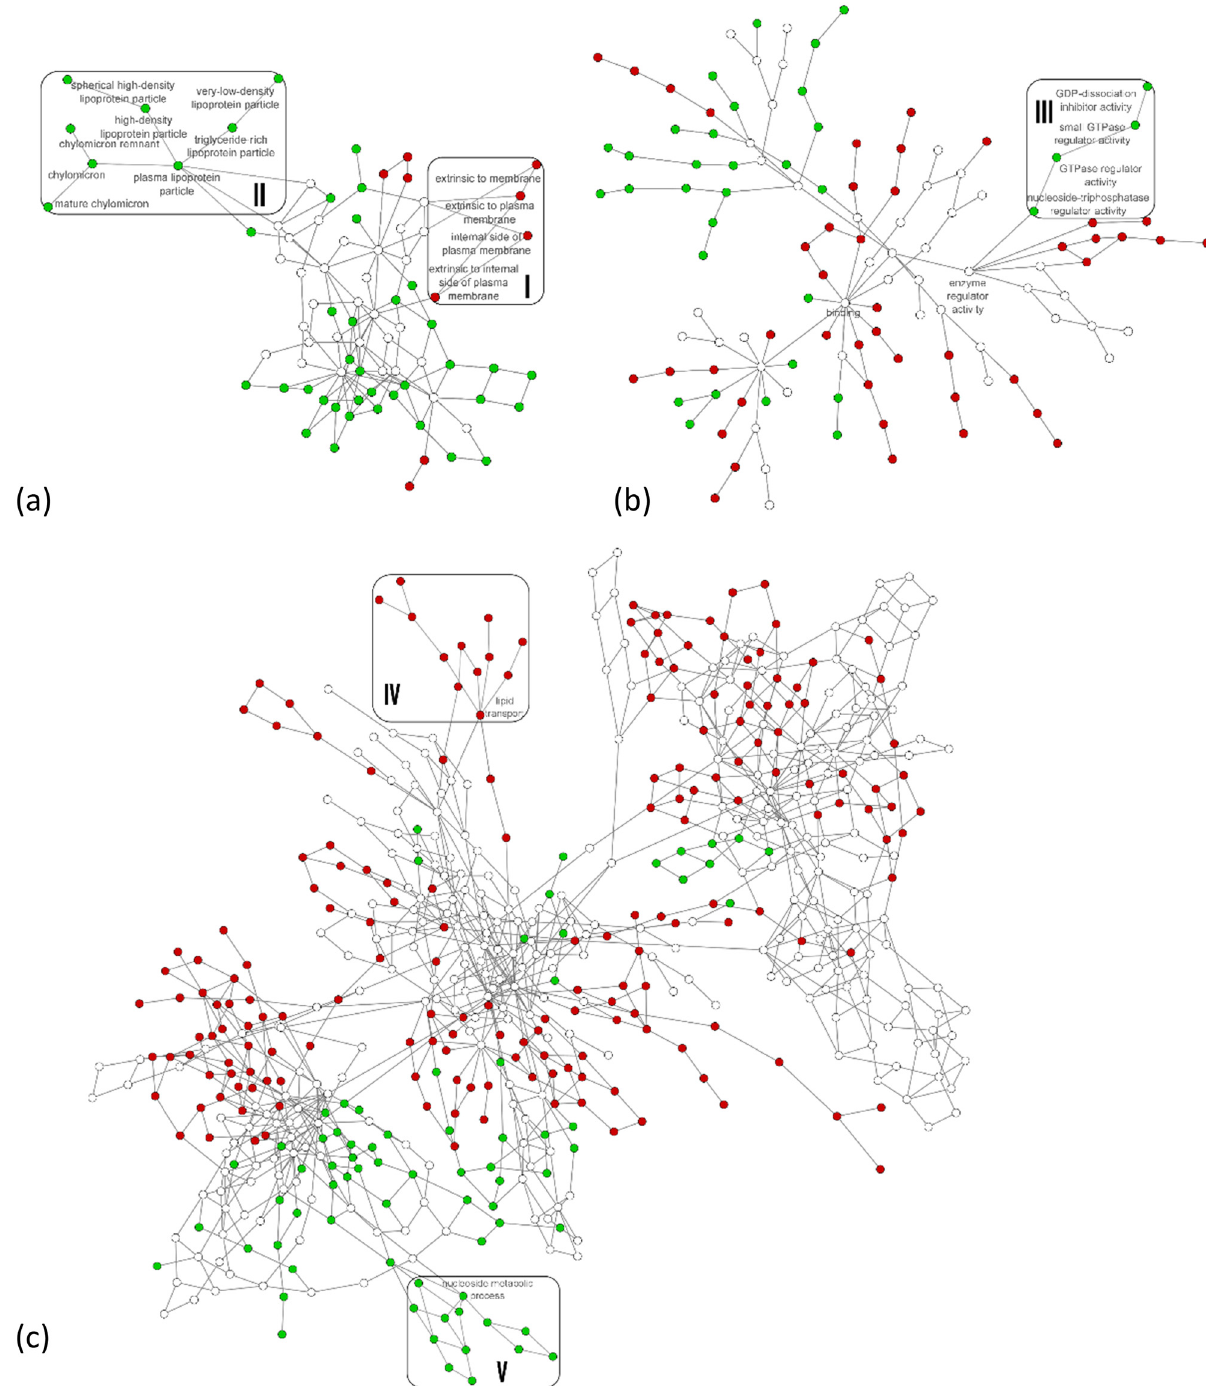
Figure 5: The hierarchical DyNet networks of GO categories: ( a ) GO cell component, ( b ) GO molecular function, and ( c ) GO biological process. Green circles – GO categories identi fi ed only by FASP protocol D1 ( Microcon ) , red circles – GO categories identi fi ed only by FASP protocol C ( Amicon ) , and white circles – GO categories identi fi ed in both